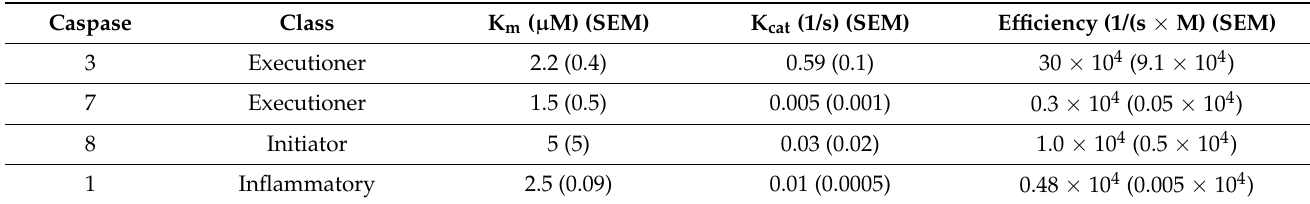
Table 1. Summary of biochemical characterization of KcapTR488.